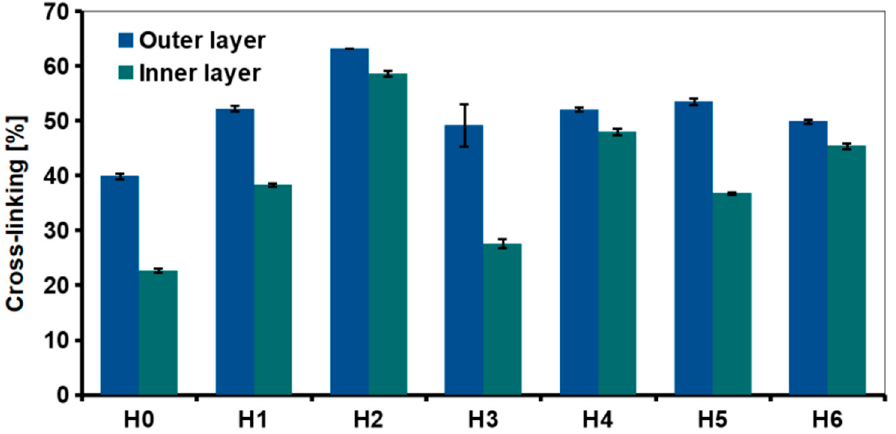
Figure 6. Degree of cross-linking in chitosan-based hydrogels (H0: chitosan (CS); H1: CS/graphene oxide (GO); H2: CS/poly(ethylene glycol) grafted graphene oxide (GO-PEG); H3: CS/reduced graphene oxide (rGO); H4: CS/GO/hydroxyapatite (HAp); H5: CS/GO-PEG/HAp; H6: CS/rGO/HAp) measured by ninhydrin